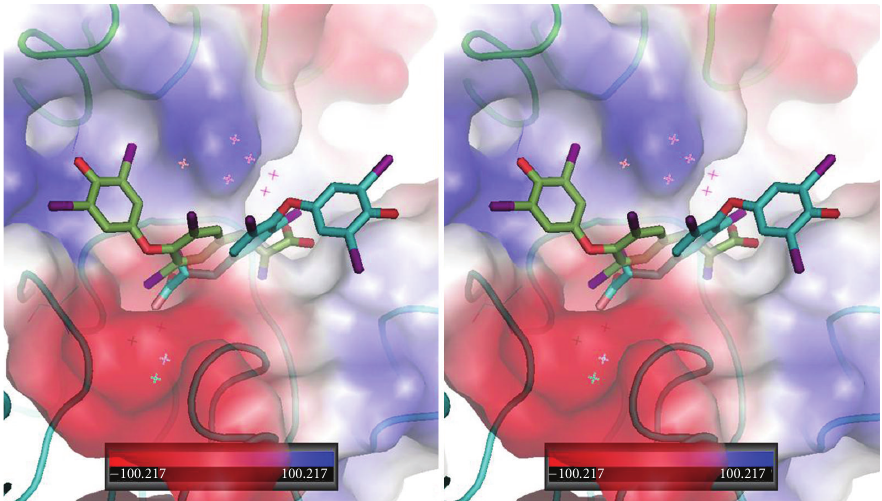
Figure 4: Stereoview of QM/MM model for T 4 (green, Ca1) and T 4 (cyan, Ca2) bound in α v β 3 integrin at the RGD binding site. Note that this energy minimum conformation has T 4 bound in a “forward” and “reverse” orientation with the phenolic ring flipped in opposite directions. The electrostatic surface for integrin is shown. Red is negative and blue is positive surface. α v domain is green and β 3 domain is cyan. Figure drawn with PyMol.